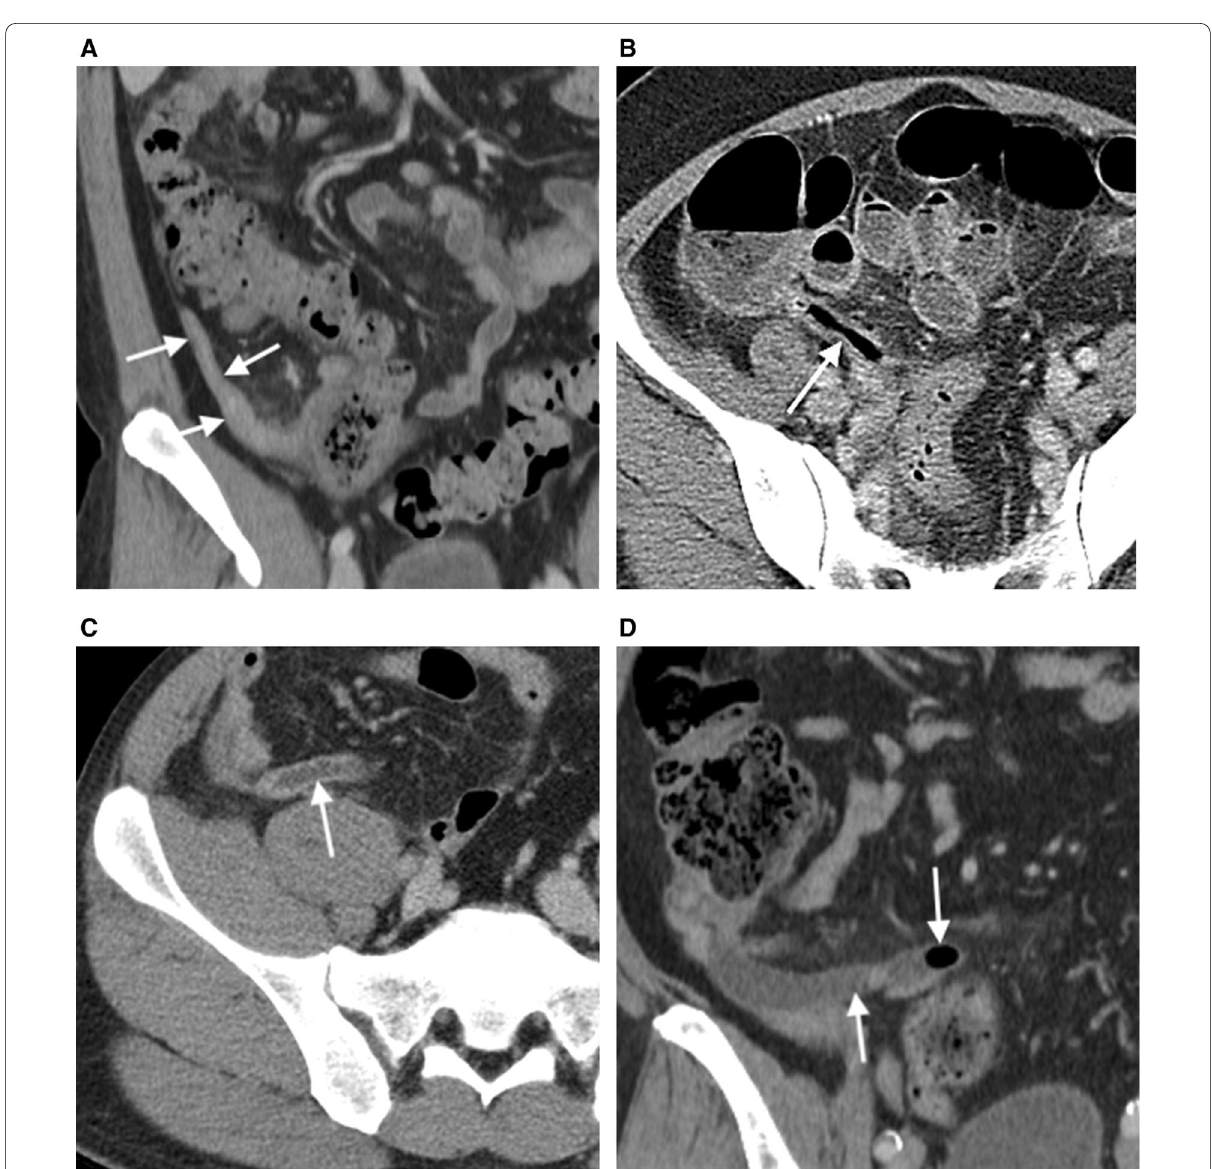
Fig. 6 Four patterns of intraluminal content in appendicitis. Axial and coronal-reformatted CT images of four different patients reveal appendices completely obliterated ( a ), filled entirely with air ( b ), fluid ( c ) or air mixed with fluid and enteric content ( d ). These four patients were diagnosed with uncomplicated (the first two), perforated and gangrenous at surgery and histopathology,